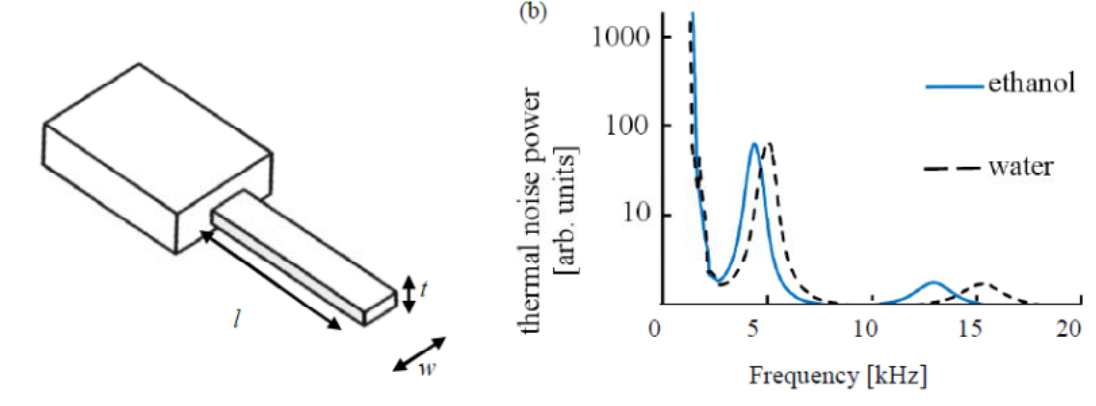
Figure 1. ( a ) Schematic of the cantilevers used in fluid measurements. ( b ) Thermal noise power spectrum for a cantilever of geometry 500 × 100 × 0.9 µm 3 , oscillating in water (black, dashed) and ethanol (blue), plotted against a logarithmic scale. The second and and Q (n) typically between 4–5 kHz and third oscillatory modes are shown, with f (n) med med 1.5–2 for the second mode and 12–15 kHz and 2.5–3 for the third mode,